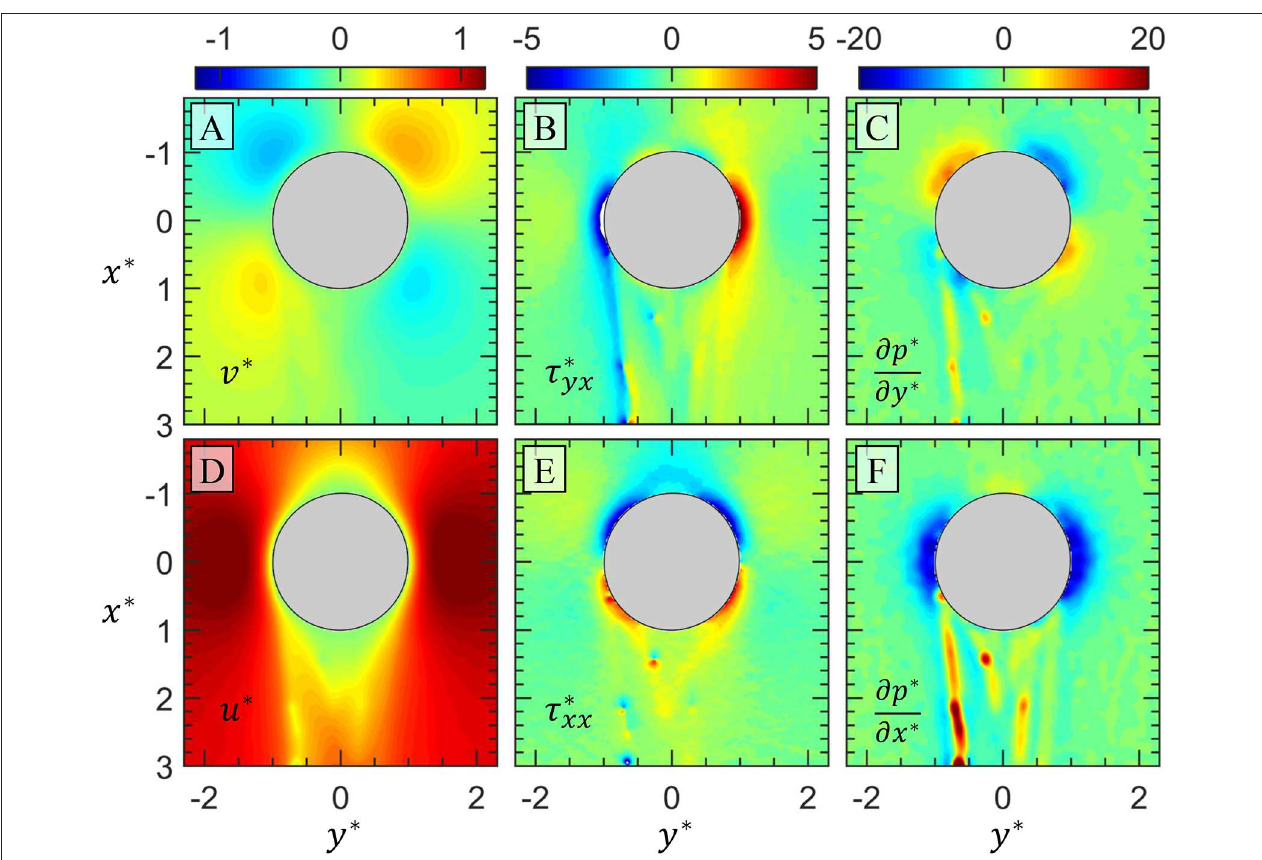
FIGURE 5 | The measured flow field around the oil drop (gray circle) after bacterial streamers have developed on the trailing half of the drop 50min after the first bacteria encounter ( Figure 4 ). In (A) the y -component and (D) x -component of velocity is shown. In (B) the shear and (E) normal viscous stresses are shown. In (C) the y -component and (F) x -component of the pressure gradients are shown. All quantities are normalized as described in the text. The magnitudes correspond to the respective color bar above each column of plots.